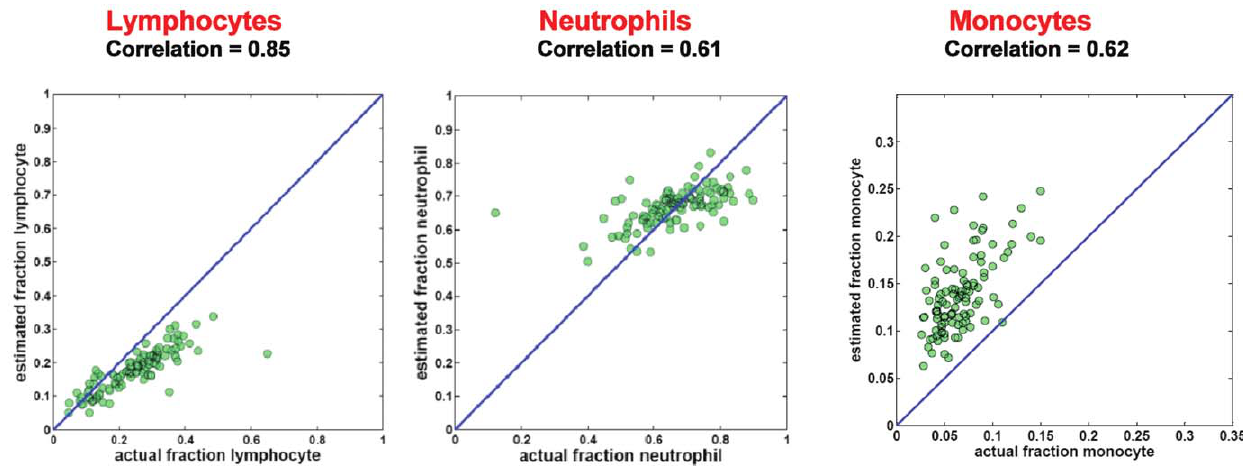
Figure 2. Comparison of CBC data and statistical deconvolution in whole blood samples. Determination in whole blood samples of relative abundance of total lymphocytes, neutrophils, or monocytes by CBC compared to determination of relative abundance by deconvolution. Each green dot here corresponds to one sample in the dataset. Diagonal lines are y=x, shown for reference, highlighting the agreement between the two methods.